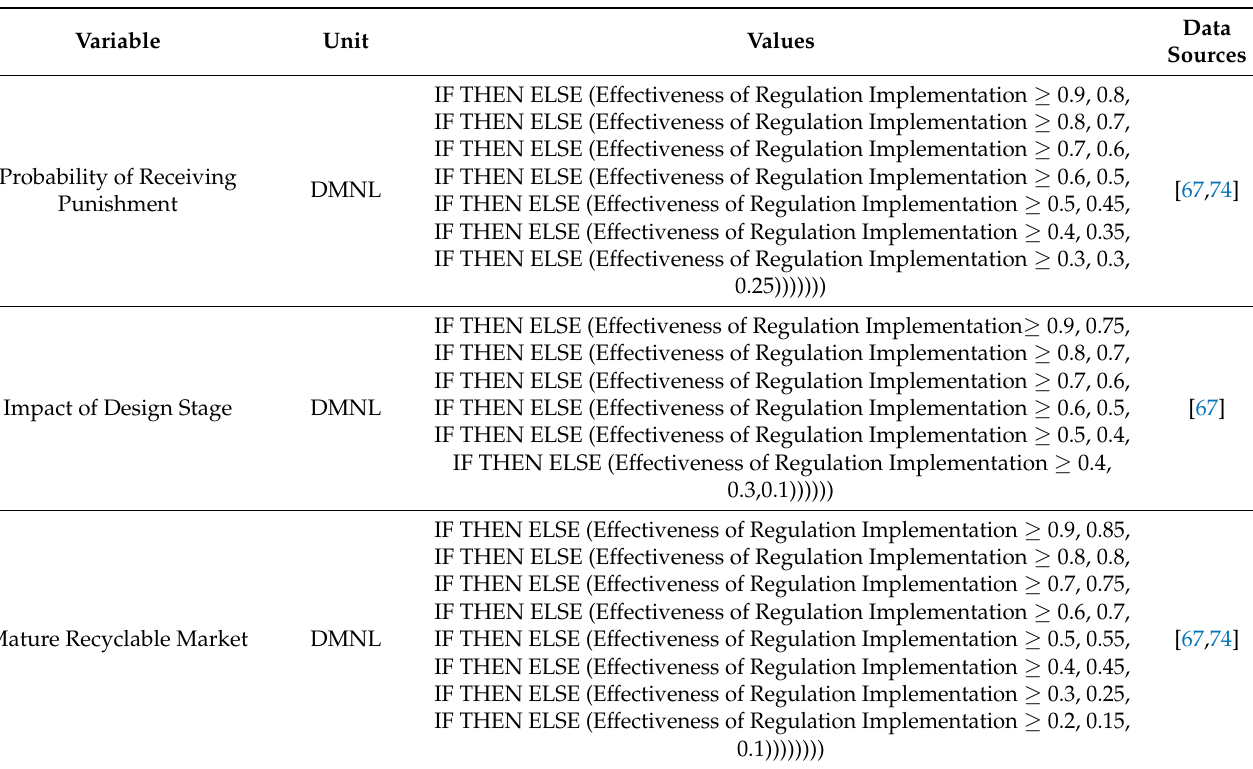
Table A4. Logical functions.